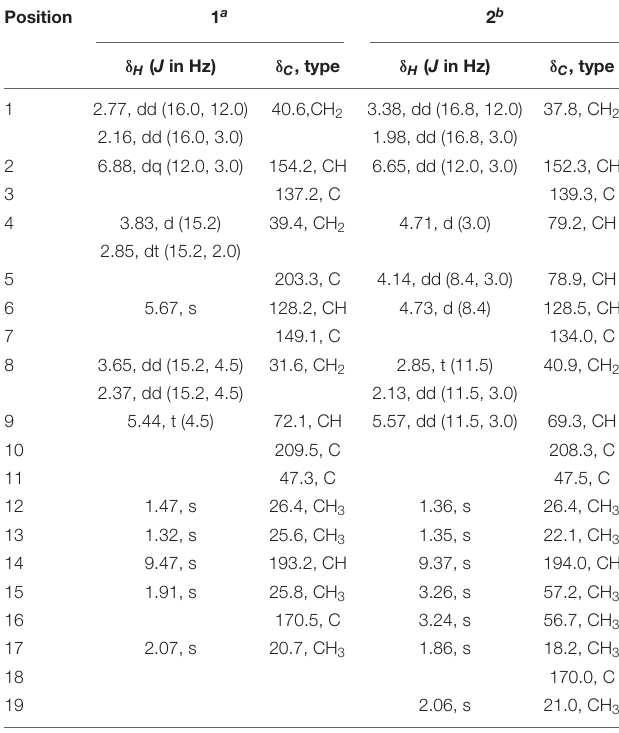
TABLE 1 | 1 H and 13 C NMR data of 1 and 2 in CDCl 3